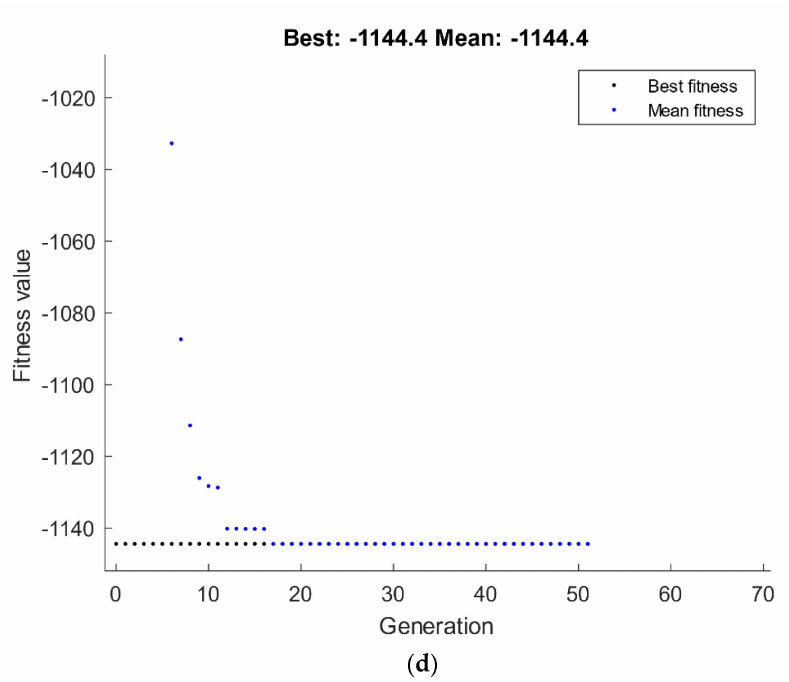
Figure 13. Optimum corrosion rate ( a , b ) and corrosion resistance ( c , d ) by GA ( a , c ) and hybrid RSM-GA ( b , d